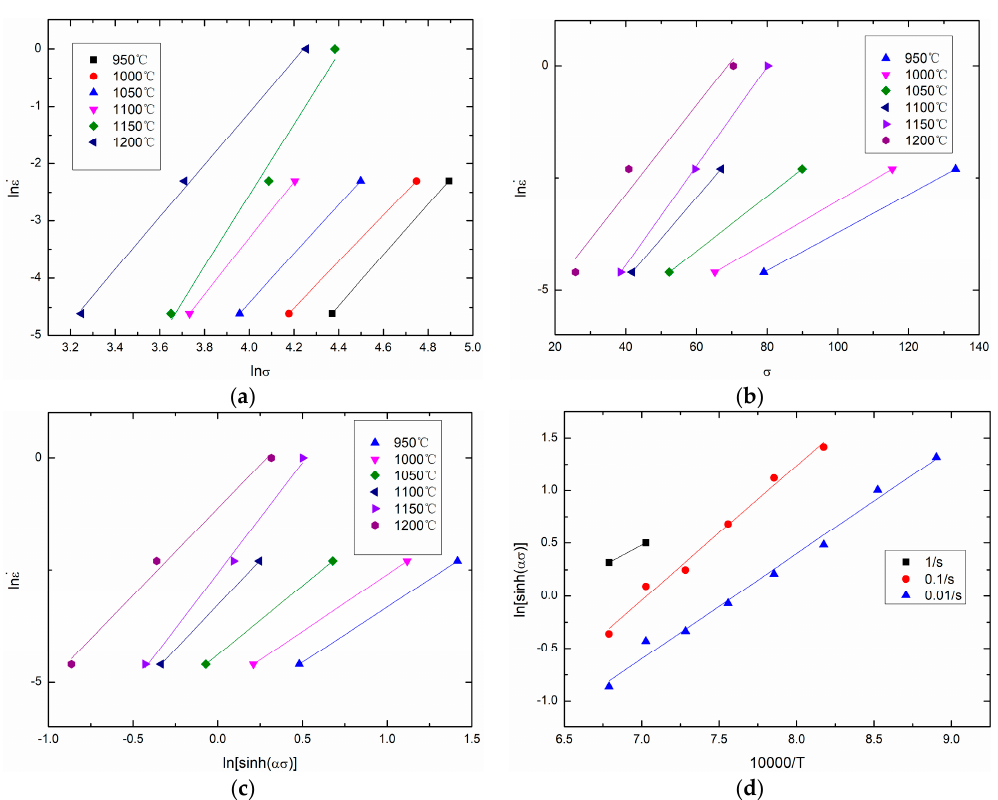
Figure 6. Calculation of material constants: ( a ) n 1 ; ( b ) β ; ( c ) n ; ( d ) Q and A .